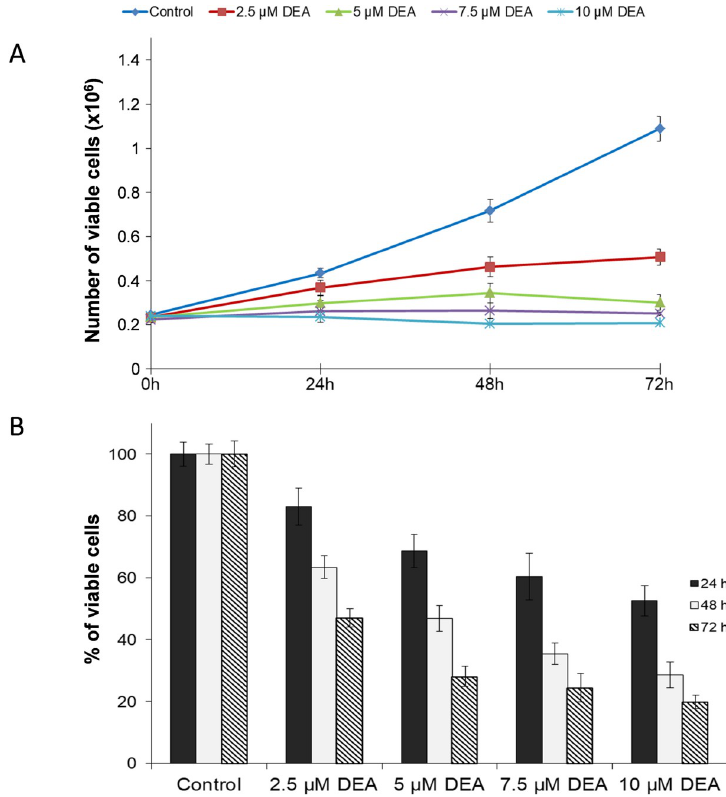
Fig 1. Effect of DEA on cell proliferation and viability of B16-F10 murine melanoma cells. The cells were incubated with the indicated concentrations of DEA for 24, 48 and 72 hours. Controls were treated with vehicle (0.2% DMSO). Cell proliferation and viability were assessed by using the SRB assay (A) and the Muse ™ Cell Count & Viability Assay (B). Data represent means ± SD of three independent experiments performed in at least quadruplicate. Data were analyzed using ANOVA with Dunett post hoc test. �� p � 0.01 and ��� p � 0.001 compared to the corresponding control group.